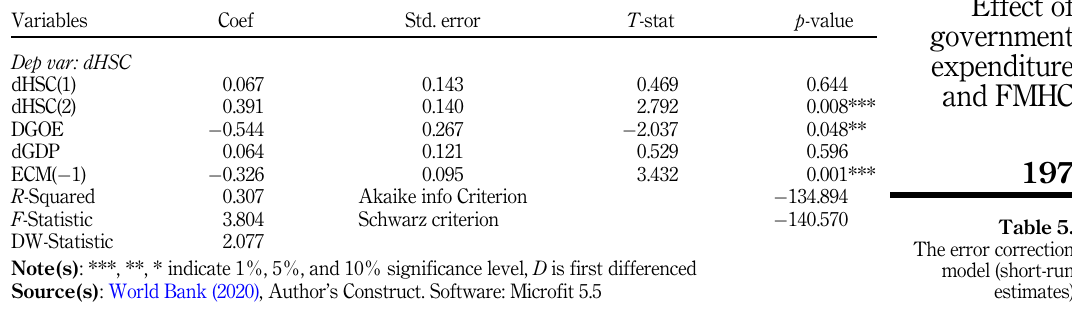
Table 5. The error